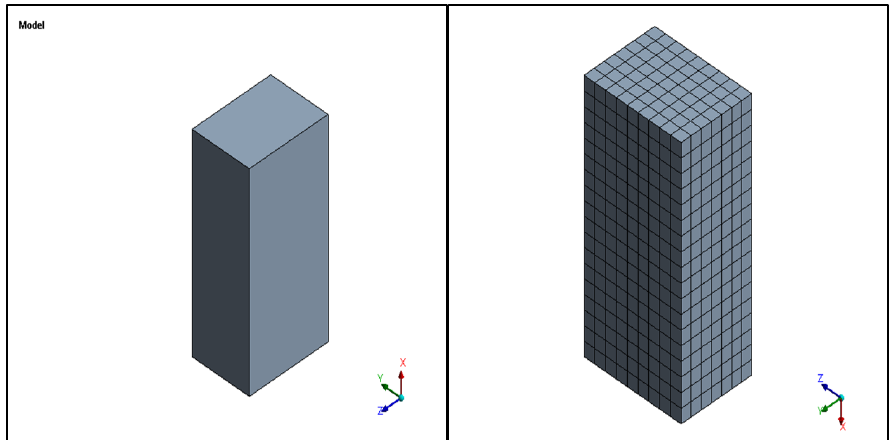
Figure 30. Model specimen of sustainable red mud bricks using ANSYS–Vertical axis (VA).